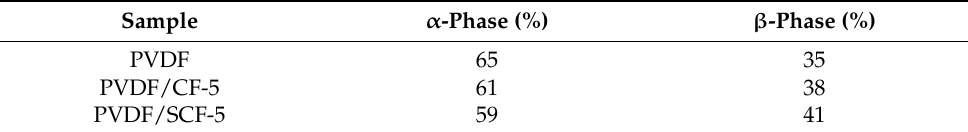
Figure 6. ATR-FTIR spectra of the pure PVDF, PVDF/CF-5, and PVDF/SCF-5 in different wavenumber ranges: ( a ) 1500–1100 cm − 1 and ( b ) 1000–600 cm − 1 . Table 2. Percentage proportions of the α - and β -phase in the PVDF composites.